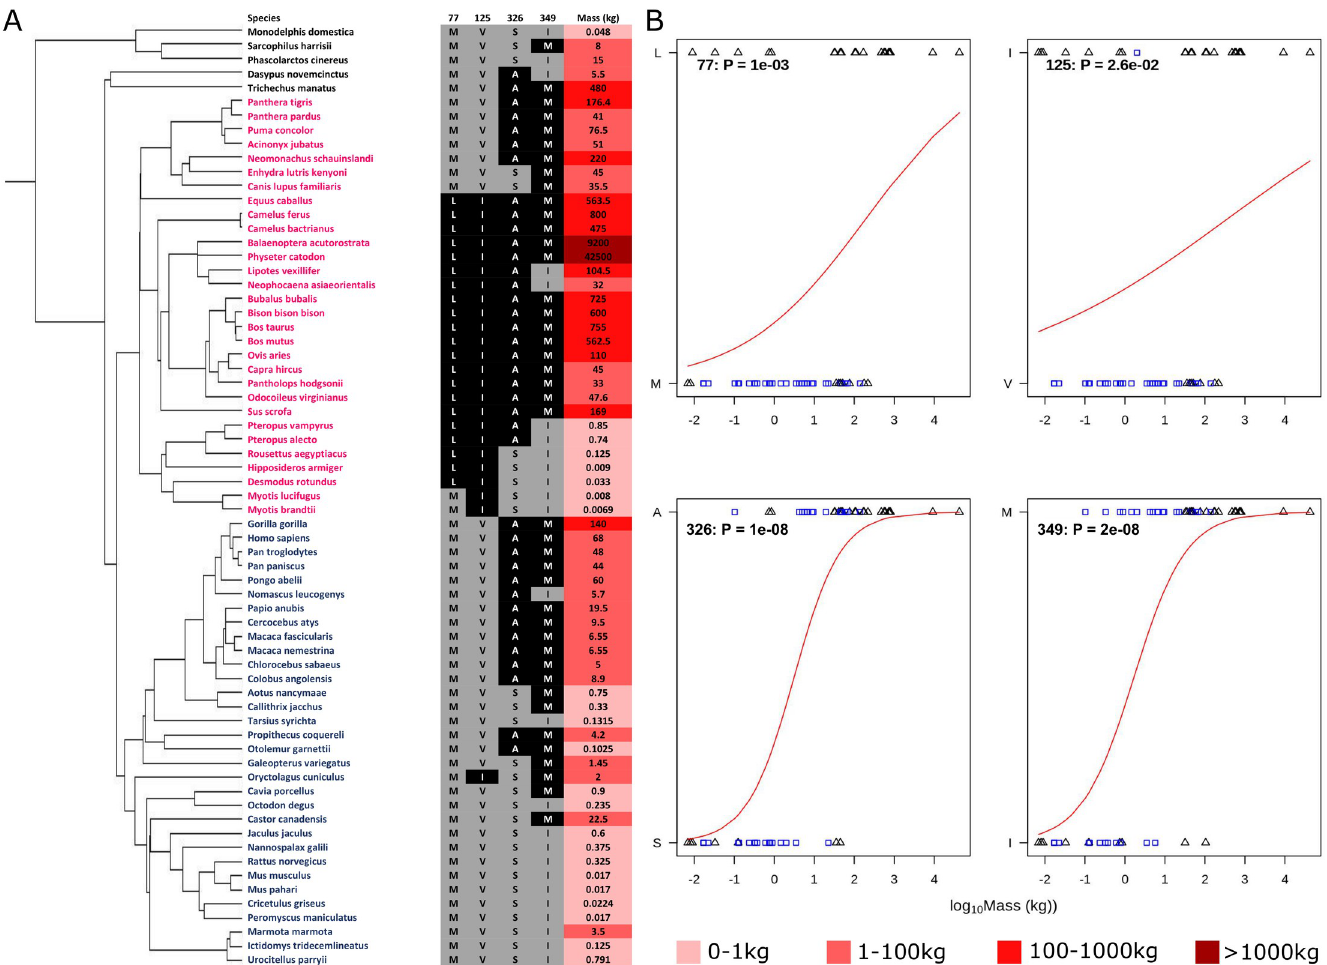
Fig 2. Residue mass transition plots for 4 representative amino acid sites. (A) Species tree of organisms used in this analysis is shown, with the amino acids present in each species at the 4 sites and the mass of the organism displayed adjacent to it. Darker reds in the mass column are indicative of a greater mass value. In this tree, species from the Euarchontoglires clade are highlighted blue, and species from Laurasiatheria are highlighted pink. (B) Binomial regression mapping the transition of the most frequent amino acid at positions in the motor region of β -myosin to the second most frequent amino acid at that position. The residue numbering is that of the human β -cardiac myosin. The blue squares are Euarchontoglires, and the triangles are Laurasiatheria. The p -value with each plot arises from a test of the null hypothesis that amino acid type is unrelated to mass. Raw data files are available at Figshare.